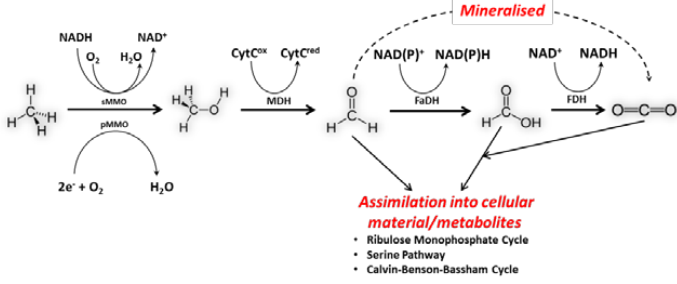
Figure 2. Generalised reaction scheme for methane oxidation via methanotrophs. Adapted from